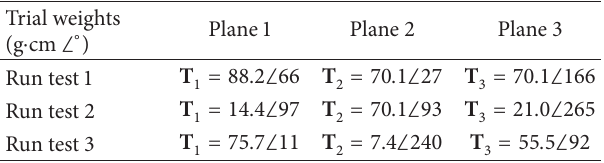
Table 1: Trail weights for the first three-order balancing. Trial weights Plane 1